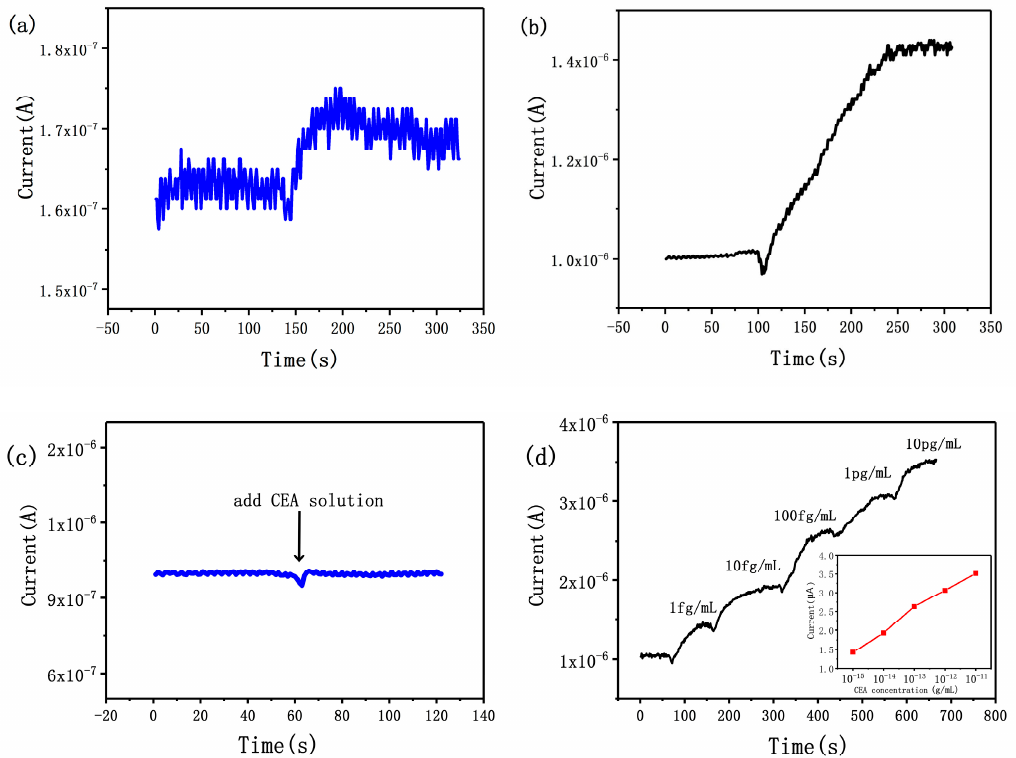
Figure 3. ( a ) Time course of current for single SiNW biosensor when 1 fg / mL carcinoembryonic antigen (CEA) solution was added. ( b ) Time course of current for SiNW array device when 1 fg / mL CEA solution was added. ( c ) Time course of current for unmodified SiNW array when 100 fg / mL CEA solution was added. ( d ) The sensor response to different CEA concentrations.